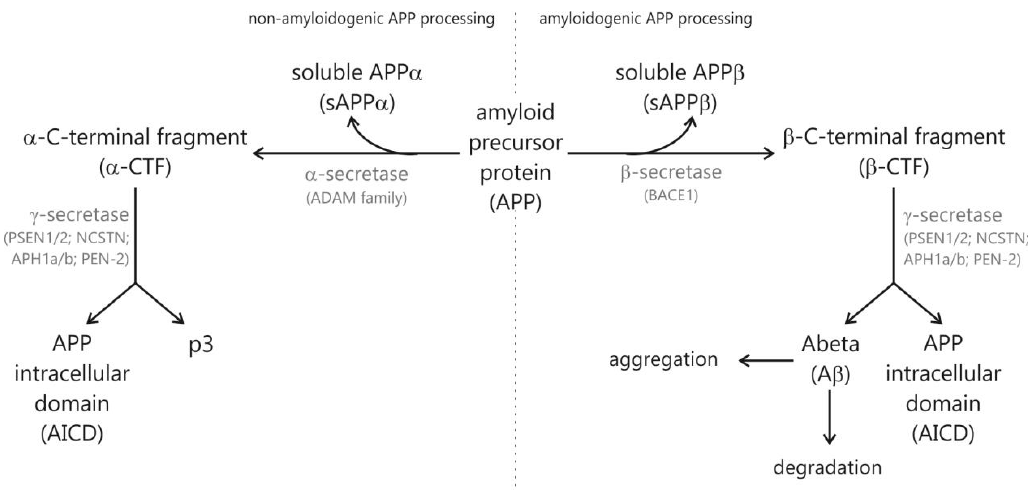
Figure 1. Schematic overview of amyloidogenic and non-amyloidogenic APP processing and generated cleavage products.